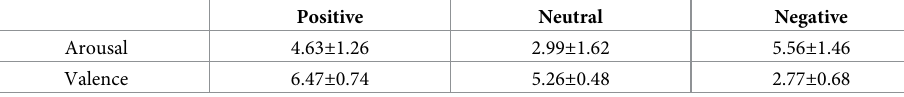
Table 1. The average value (mean ± S.D.) of valence and arousal in SAM (Additional 15 volunteers).